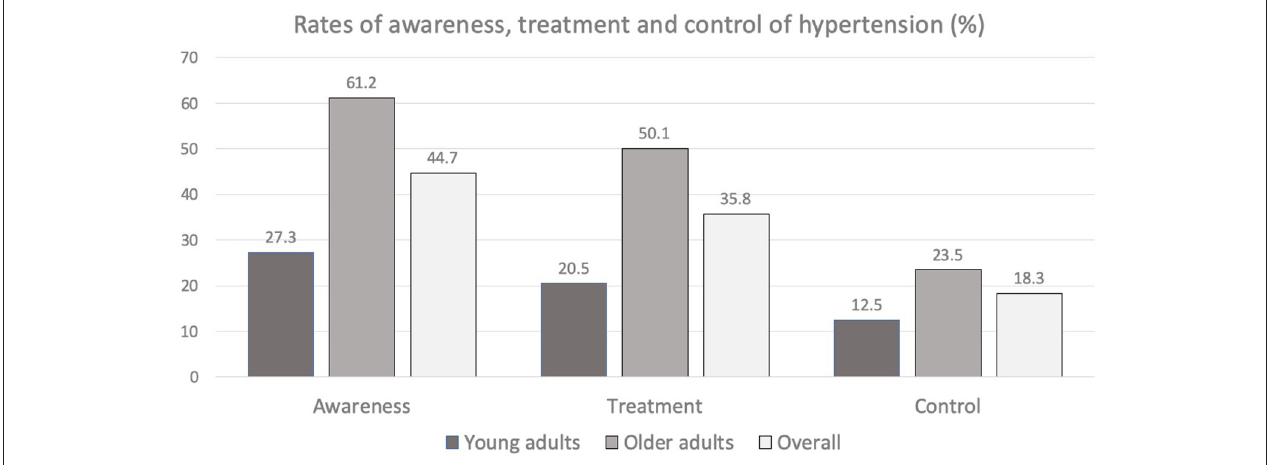
FIGURE 1 | Rates of awareness, treatment and control of hypertension among young adults and older adults.